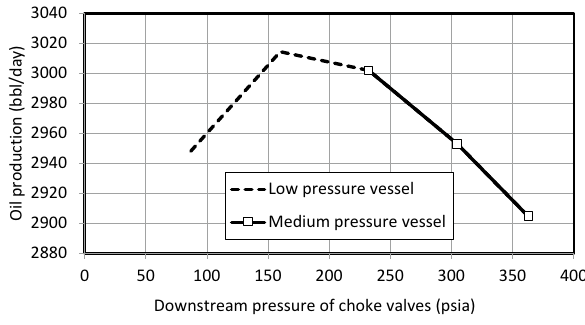
Fig. 4 Variation of oil productions from Well A considering both choke valves and pressures of vessels on the